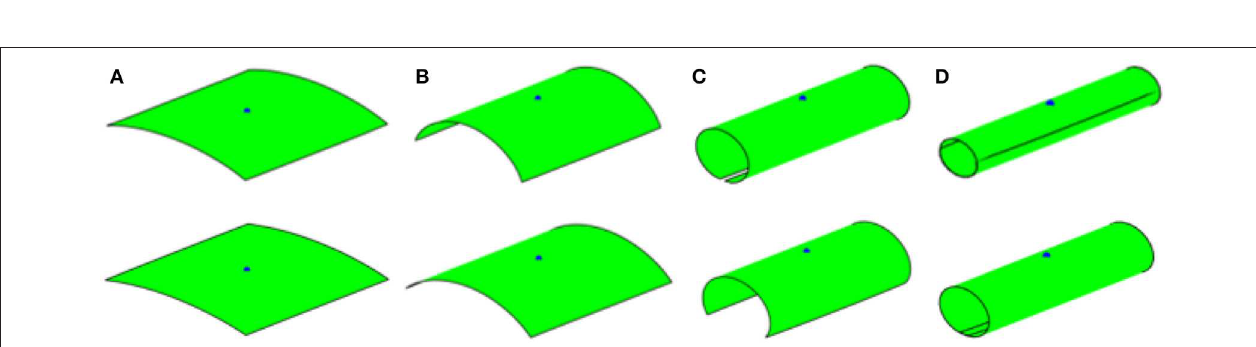
Frontiers in Materials |